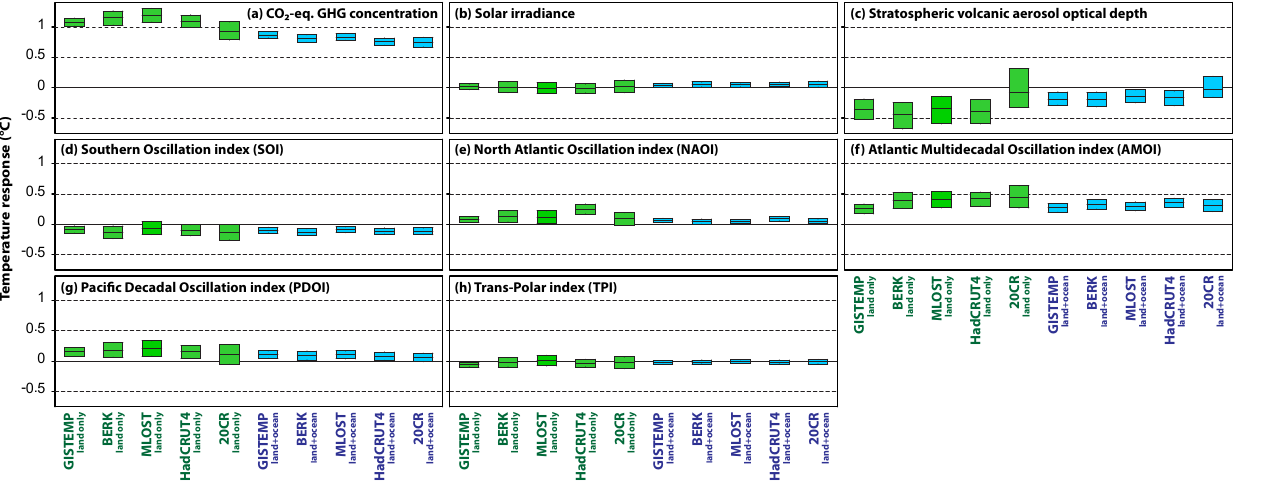
Figure 4. Regression-estimated responses ( ◦ C) of global (blue) or global land (green) monthly temperature anomalies to pre-selected char- acteristic variations of individual explanatory variables (specified in Fig. 1). Time shift of + 1 month (predictor leading temperature) was applied for solar irradiance, + 7 months for volcanic aerosol amount, + 2 months for SOI. The boxes illustrate the 99% confidence intervals, calculated by moving-block bootstrap (12-month block size). The 20CR-based results are shown for the series averaged over the 60 ◦ S to 75 ◦ N area. Obtained for the 1901–2010 period; see Figs. S2 and S3 for results over the 1901–1955 and 1956–2010 sub-periods; Fig. S4 for visualization of individual temperature series and their regression-based